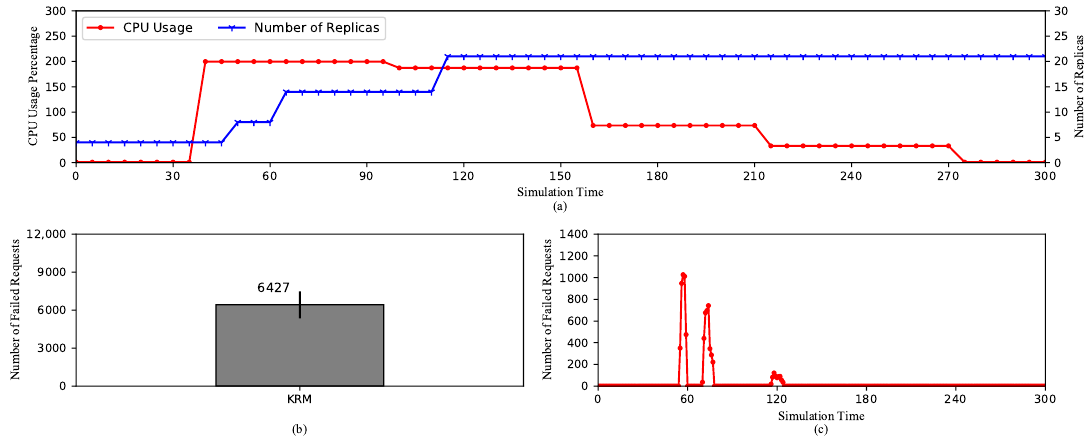
Figure 3. HPA using default Kubernetes Resource Metrics (KRM). ( a ) The average CPU usage and the scaling of the replica set. ( b ) The total number of the failed requests. ( c ) The timeline of the failed